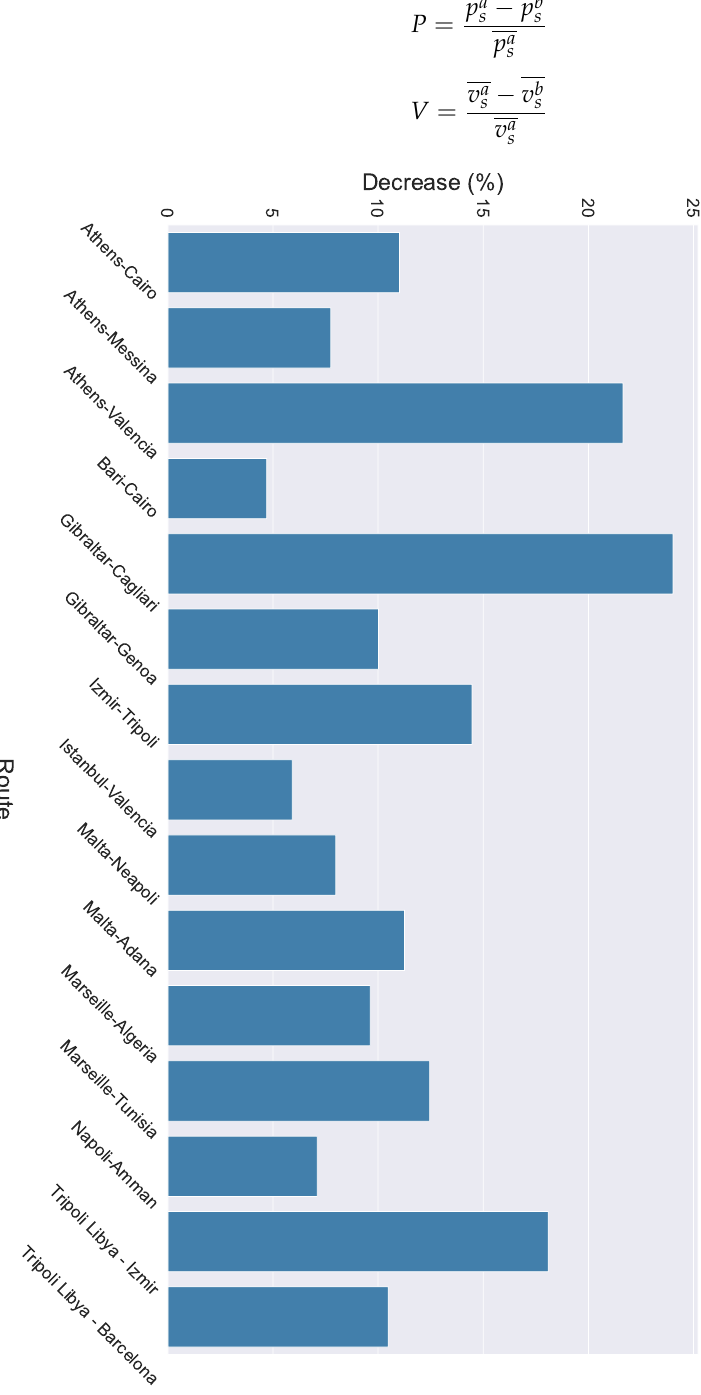
Figure 7. Decrease of the wave period when the alternate routes are